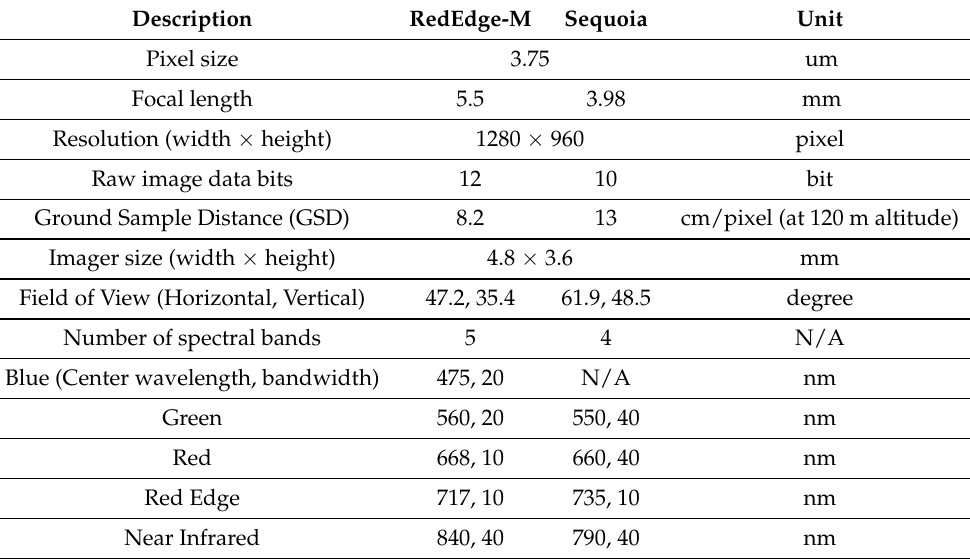
Table 3. Multispectral camera sensors specifications used in this